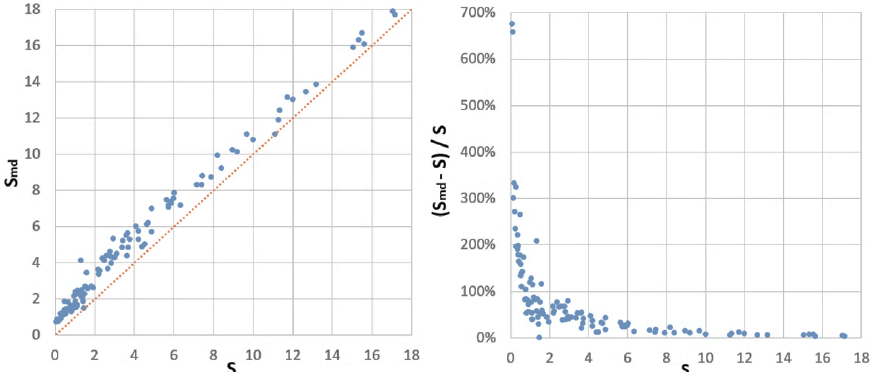
Figure 4. Bias ( left ) and relative error ( right ) between calculating the dimensionless eroded area of a section from an averaged profile ( S ) or from averaging damage indexes from each profile ( S md ). Despite, in theory, both options should yield exactly the same results, in this case, the differences seem to be derived from the smoothing method based on cubic splines applied to the profiles: S md is calculated from smoothed profiles, whereas the averaged slope for evaluating S is calculated smoothing the profile resulting from averaging the measurements at each fixed chainage. Figure based on the experimental data of Bradbury et al. [28].